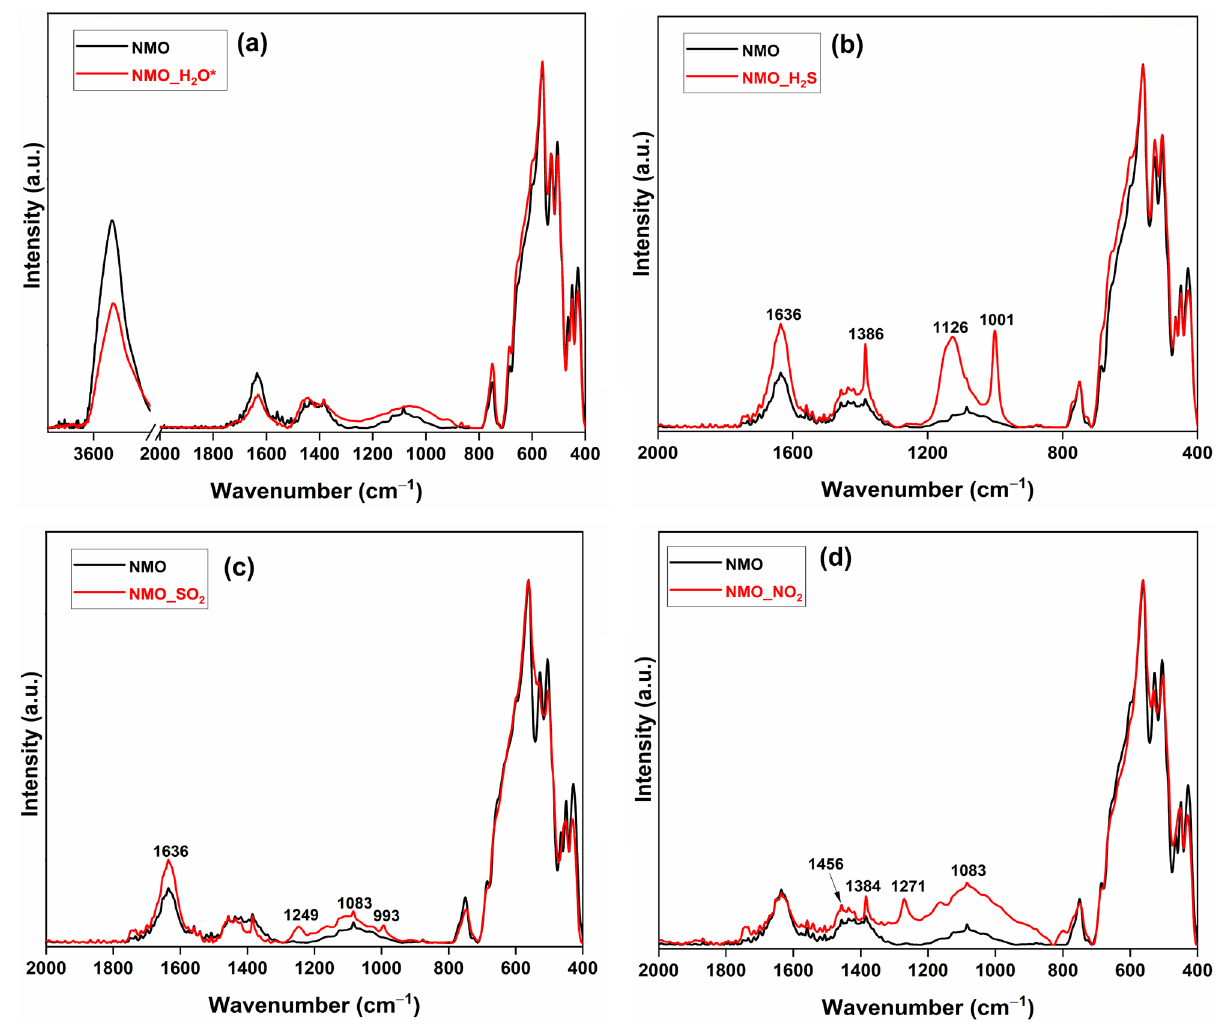
Figure 6. FTIR spectra of ( a ) water-saturated NMO after complete drying; ( b ) NMO_H 2 S; ( c ) NMO_SO 2 ; ( d )